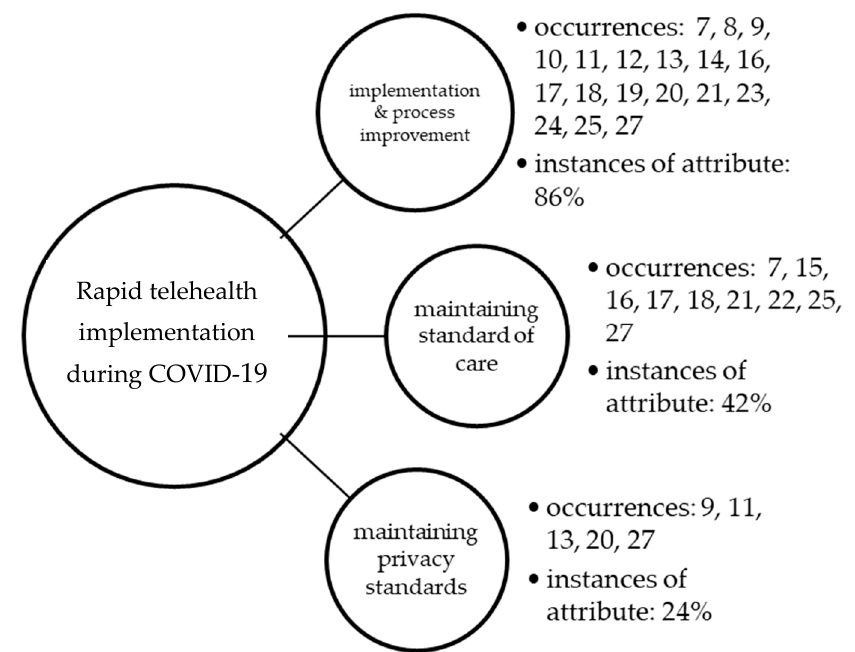
Figure 2. Occurrences of underlying themes as observed in the literature .